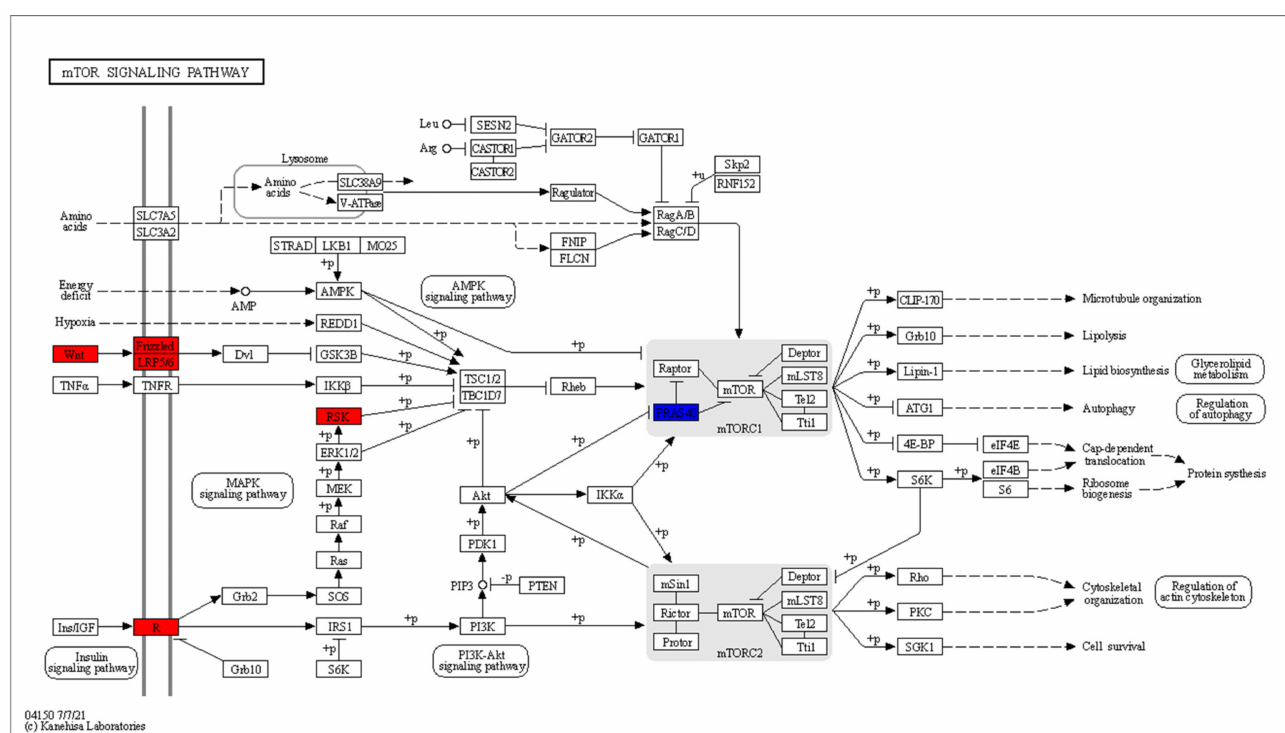
Figure 15. The differentially expressed genes of RA CD8 + Temra cells in the mTOR pathway. Red indicates upregulated genes and blue indicates downregulated